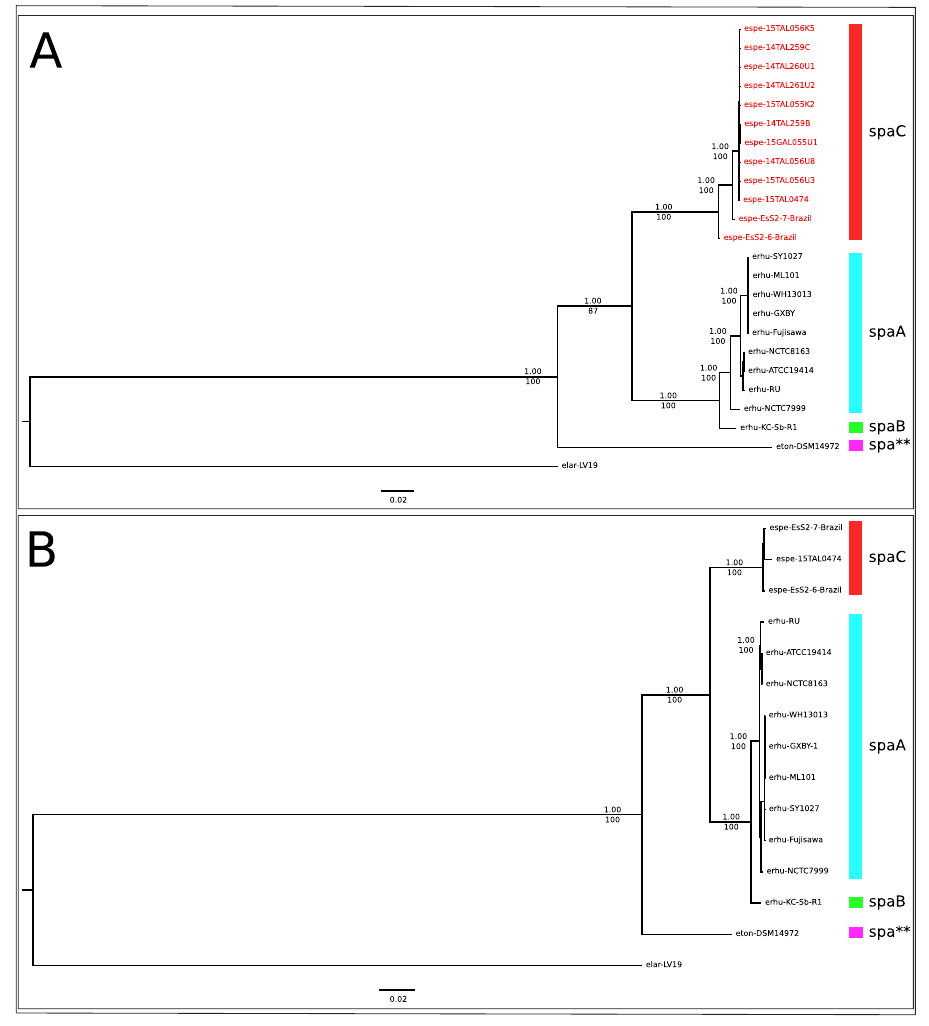
Figure 2. Phylogenetic reconstruction of Erysipelothrix genus using Multilocus Sequence analysis (MLSA) and phylogenomic analysis. Legend: ( A ) MLSA Bayesian phylogenetic tree based on the partitioned supermatrix of seven genes (galK, gpsA, ldhA, prsA, pta, purA and recA). ( B ) Phylogenomic Bayesian phylogenetic tree based on the partitioned supermatrix of 506 single-copy core-genome orthologous proteins. Posterior probability values of support obtained in Bayesian Analysis (BA) are shown above nodes. Rapid bootstrap values obtained in Maximum Likelihood (ML) analysis are shown below nodes. Species were indicated as described Supplementary Table